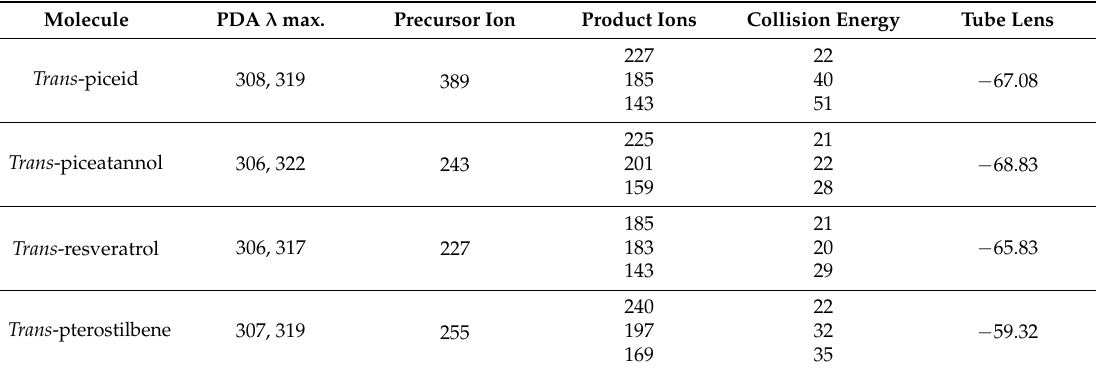
Table 3. Retention time, λ max, and mass spectrometry conditions of trans